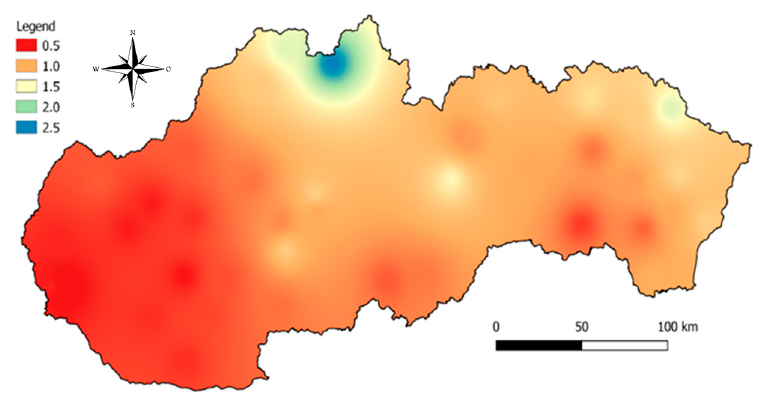
Figure 3. Ratio of average precipitation to average reference evapotranspiration (P / ET 0 ) in 2017.